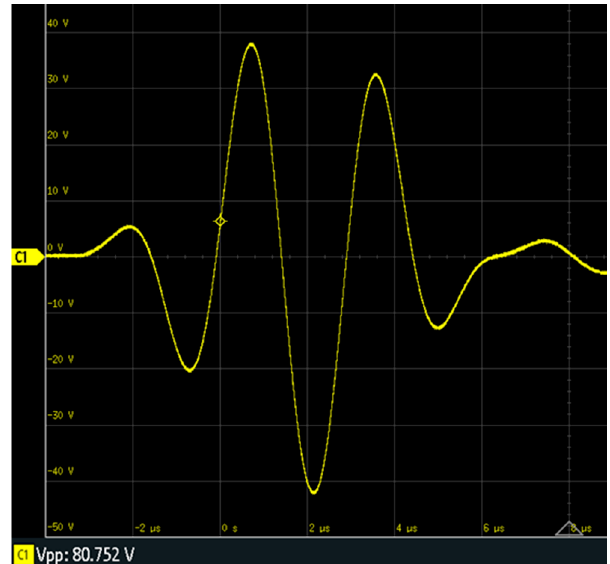
Figure 6. Signal applied to E5 in the UGWT according to procedure P1.